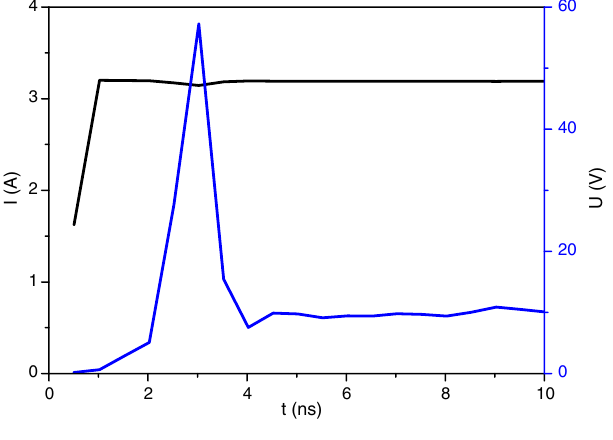
FIG. 3. Current and voltage waveforms.